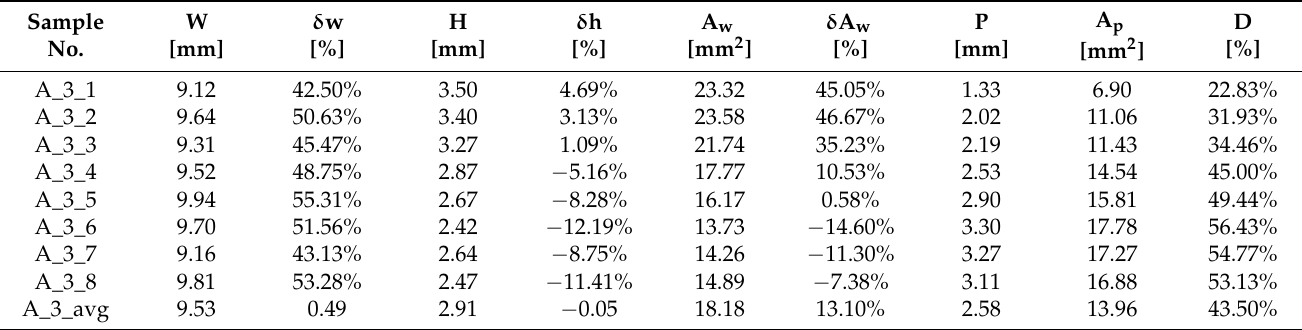
Table A3. Measurements of dimensional features of 3rd parameter set of Wire A—wire feed